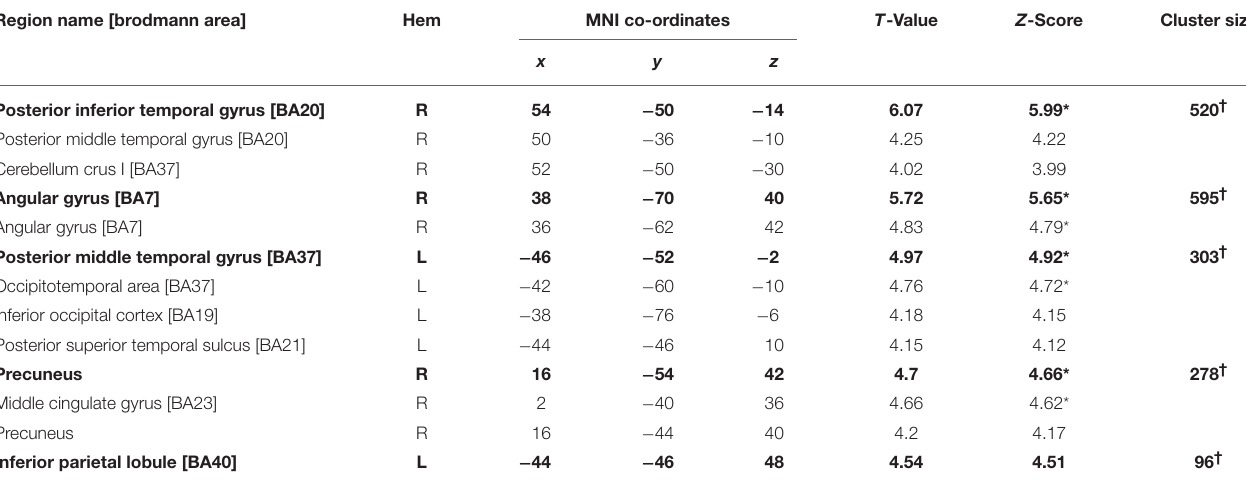
TABLE 1 | Summary of results for the contrast looming—receding in Patient